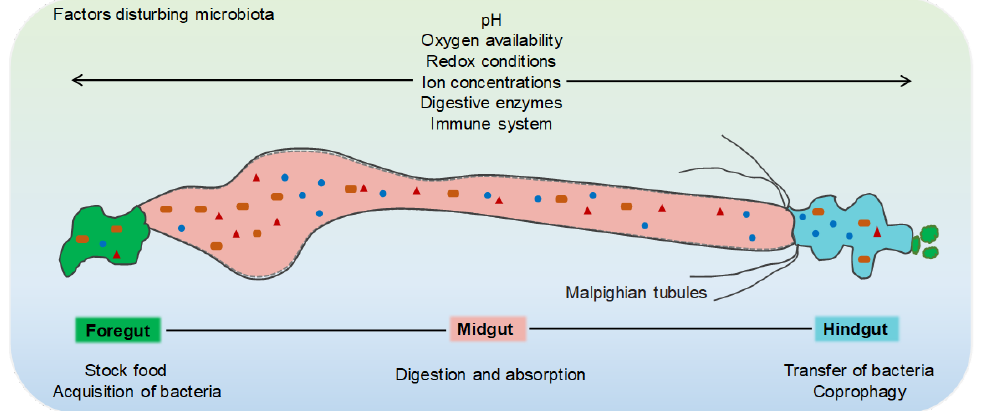
Figure 1. Gut structure of lepidopteran insects. Take the B. mori as an example. The foregut and hindgut are lined by a cuticle layer (thick black line), and the midgut secretes a peritrophic matrix (dashed line). Factors influencing the composition of the gut microbiota of lepidopteran insects include host development, pH, oxygen availability, redox conditions, ion concentrations, digestive enzymes and the immune system in different gut compartments, available sources for bacterial acquisition, and the capability to transfer bacteria to progeny. Green indicates the foregut, red indicates the midgut, and blue indicates the hindgut.